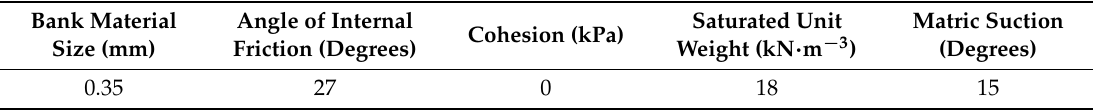
Table 3. Summary of soil parameter values used for the theoretical bank to calculate factor of safety in bank model BSTEM 5.2